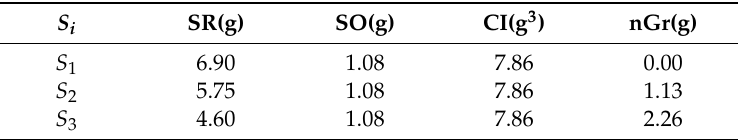
Table 1. Sample compositions.